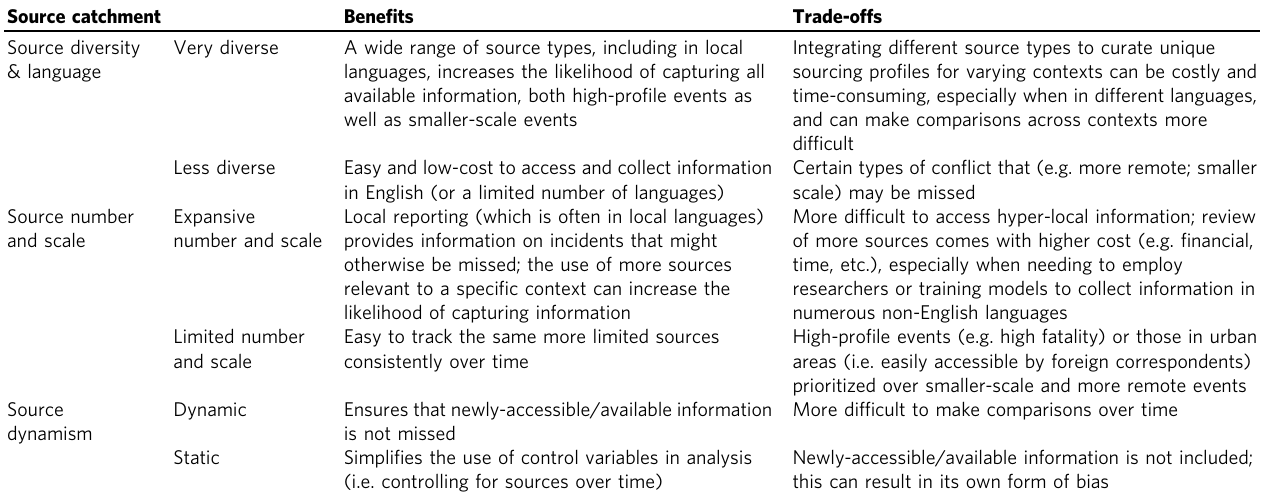
Table 3 Datasets ’ sourcing catchment strategies & their bene fi ts and